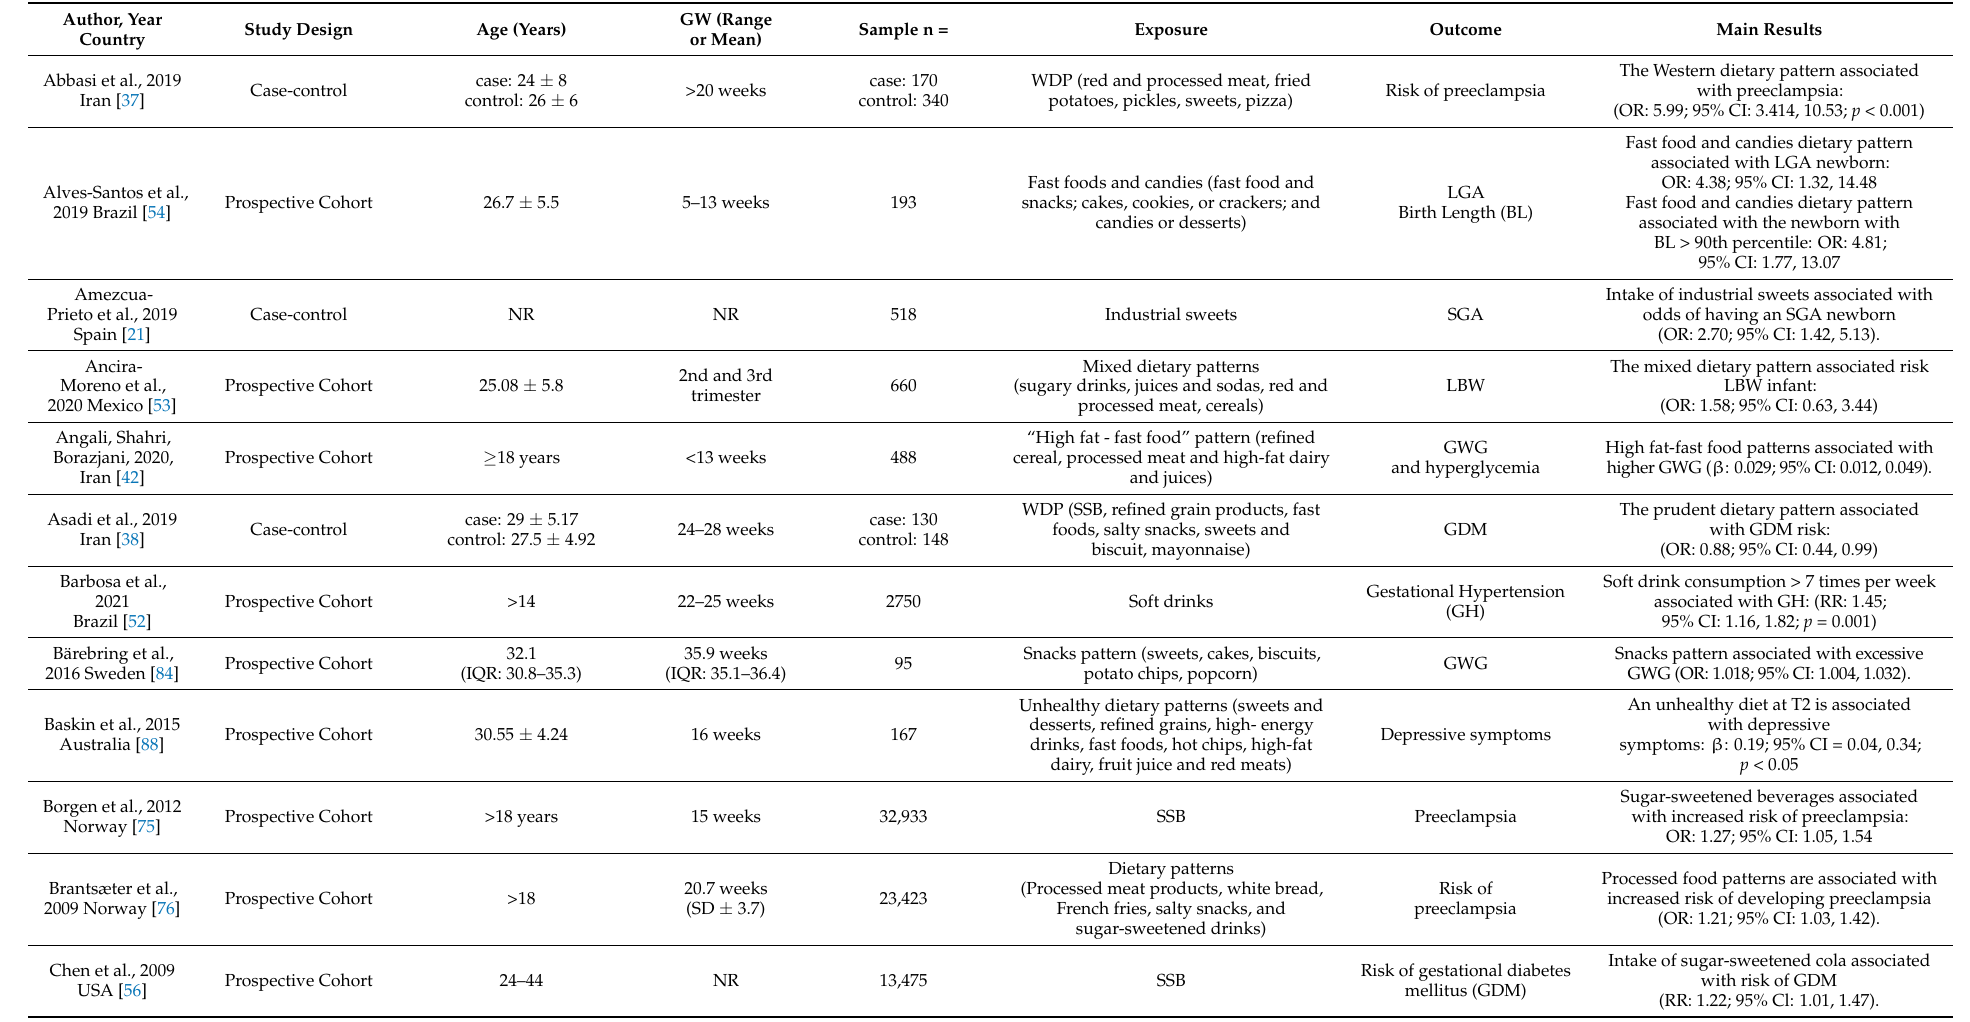
Table 1. Summary of included studies